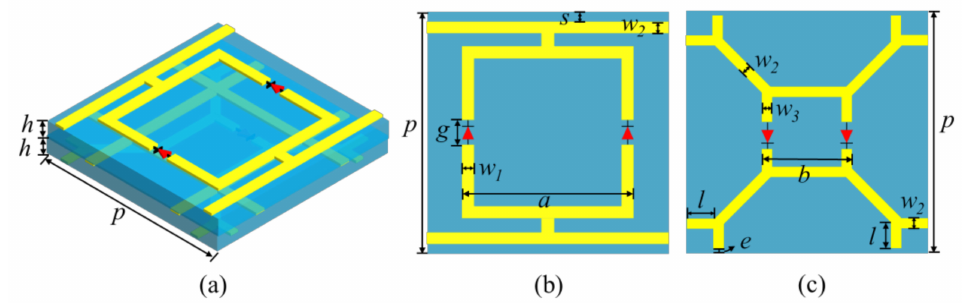
Figure 2. Geometry of the proposed meta-atom. ( a ) 3-D view of the structure. ( b ) The top layer. ( c ) The bottom layer.